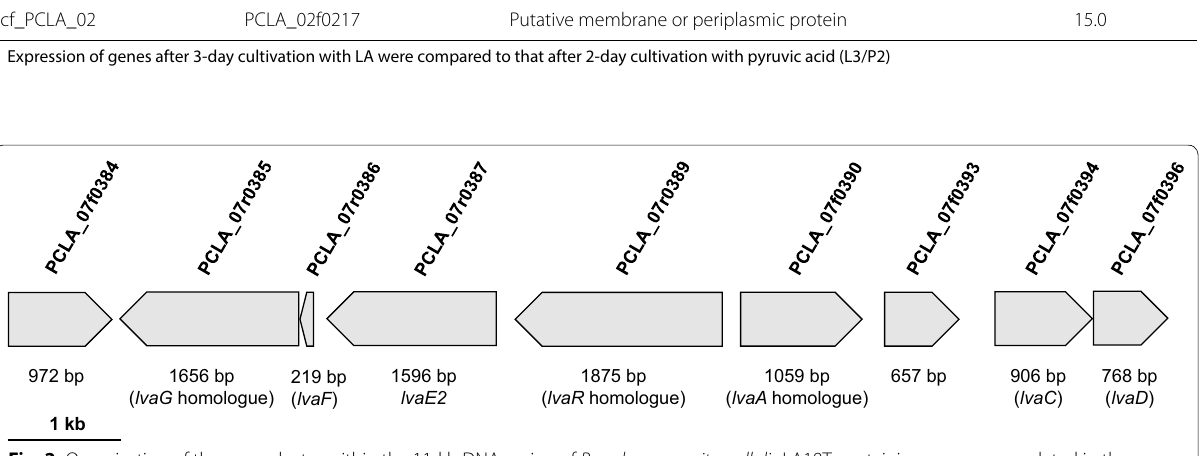
Fig. 2 Organization of the gene cluster within the 11-kb DNA region of Pseudomonas citronellolis LA18T containing genes upregulated in the presence of levulinic acid. Blocks indicate the sizes, locations, and directions of transcription of the open reading frames (ORFs). ORF numbers and their sizes are noted beneath the